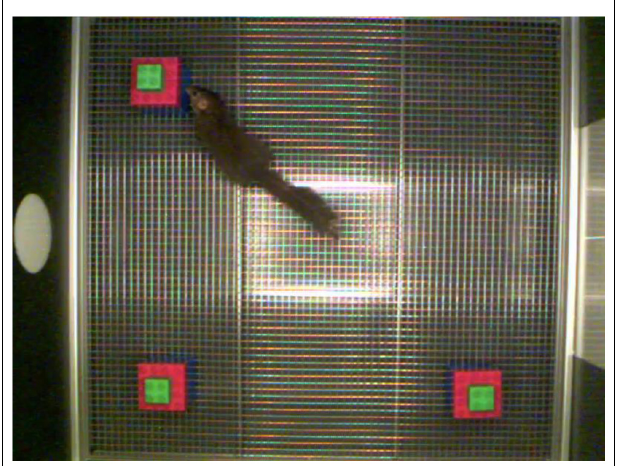
FIGURE 1 |Top view of the experimental setup, illustrating the relative size of the objects and the tree shrew during exploration of one object.